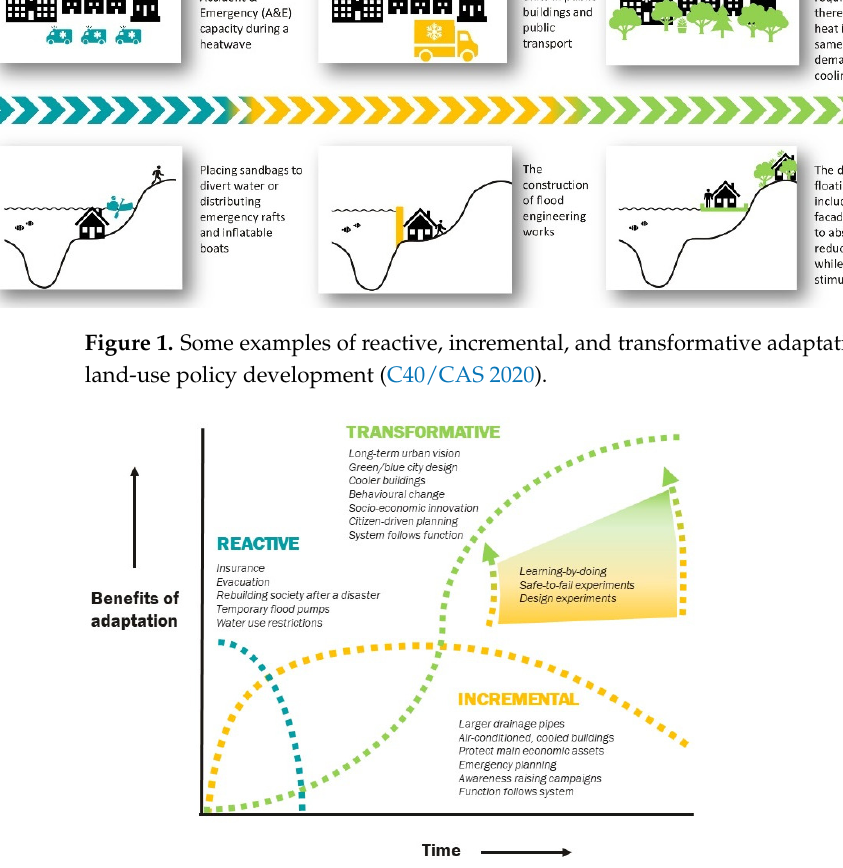
Figure 2. Benefits of transformational adaptation as compared to incremental (preventive) and reactive adaptation.